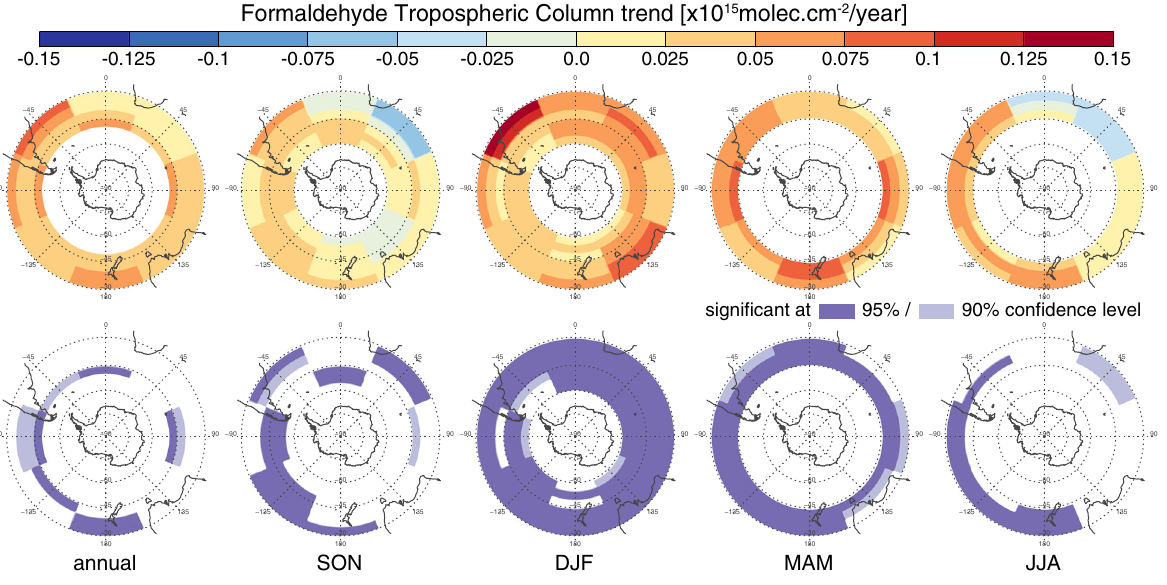
Fig. 10 Spatial distribution of linear trends (top, ×10 15 molecule cm − 2 year − 1 ) and p values (bottom) for deseasonalized tropospheric HCHO result in the Southern Hemisphere 30 – 60° S) from 2005 to 2016. The first column shows the annual trend; other columns show seasonal trends. The regions showing statistically significant trends are colored deep purple ( p < 0.05) or light purple ( p < 0.10)